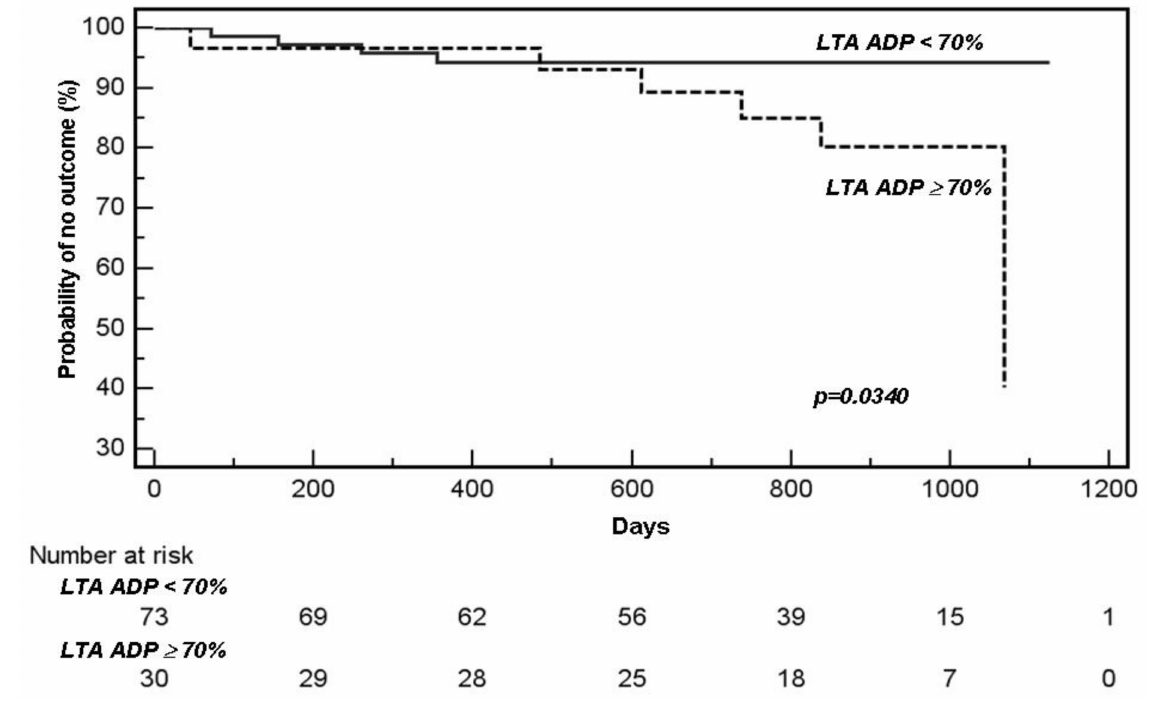
Figure 2. Kaplan–Meier curves of group considered “aspirin resistant” versus not “aspirin resistant” by light transmission aggregometry (LTA) using